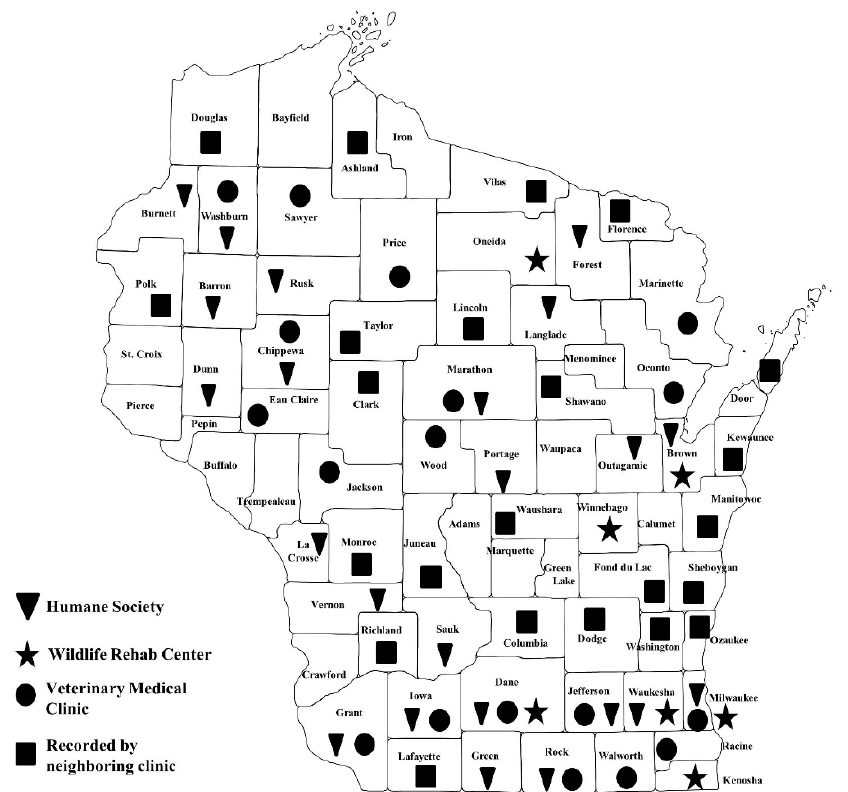
Figure 1. Wisconsin counties where veterinary, humane society, and licensed animal rehabilitators surveyed animals and submitted ticks for identification .